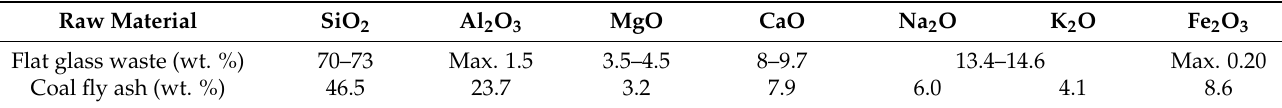
Table 1. Oxide composition of raw